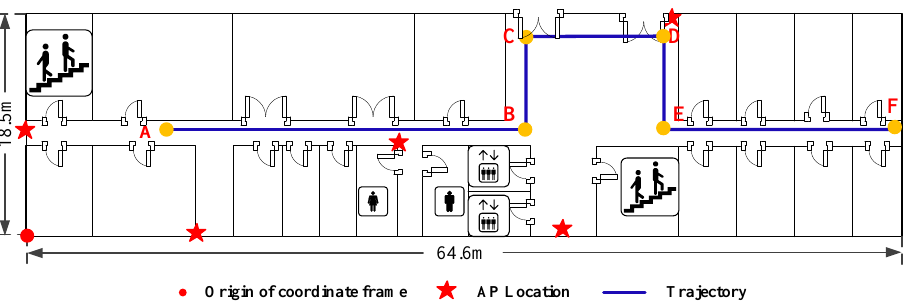
Figure 19. Testbed for dynamic